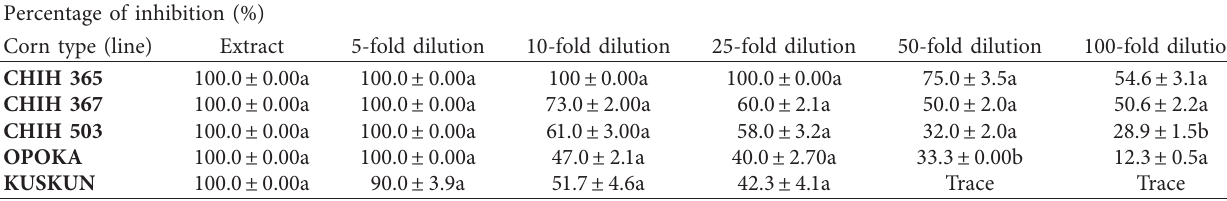
Table 5: Antidiabetic activity of the tested extracts expressed in % inhibition of α -amylase. Percentage of inhibition (%)